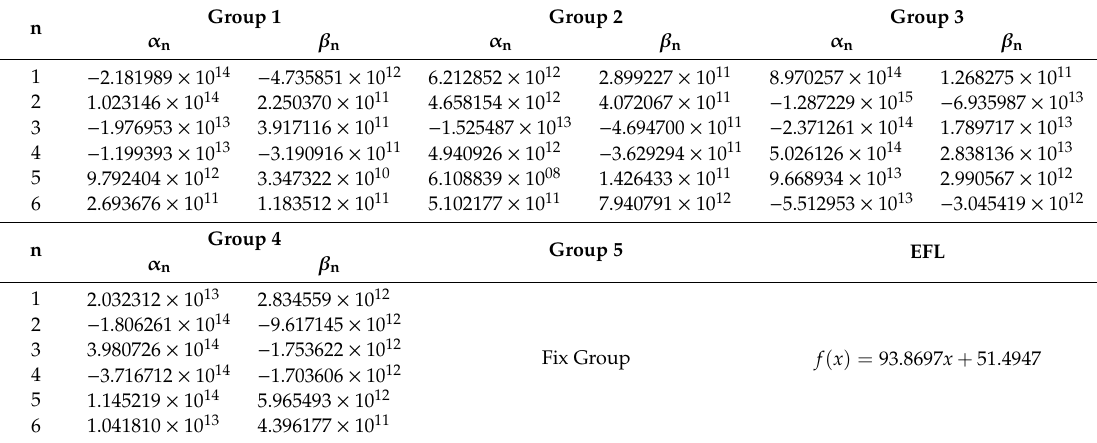
Figure 13. Graphs according to Table 13. ( a ) Zoom locus of each lens group, ( b ) EFL of this optical system, and ( c ) error for image plane. Table 14. Coefficients of the rational function for the locus of each lens group calculated by the Padé approximation in Table 13.